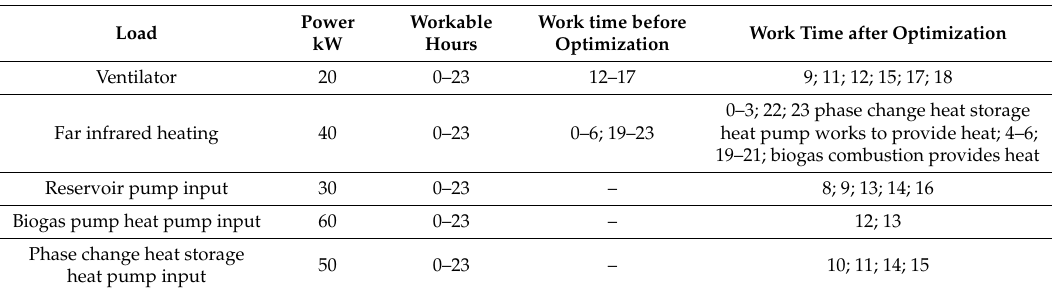
Table 4. Timetable of loads and energy stores working time before and after optimization on a cloudy winter day after a sunny